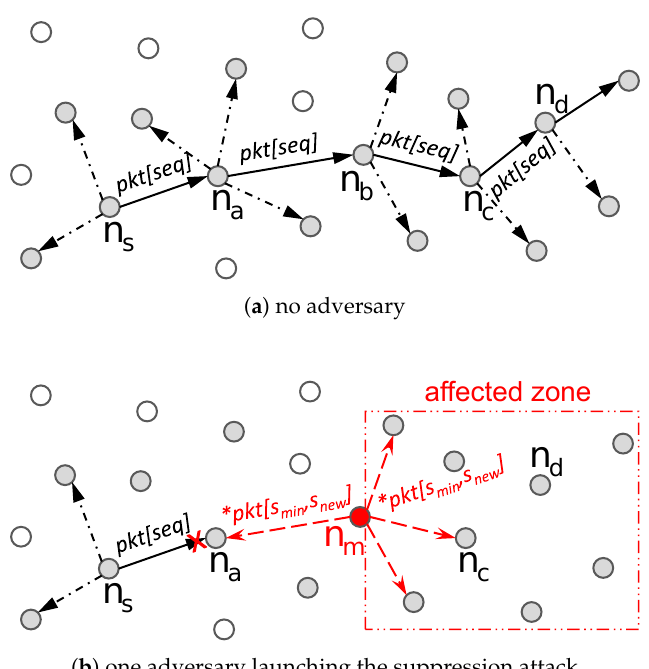
Figure 2. An example of multicasting a data message: ( a ) no adversary; and ( b ) one adversary launching the suppression attack.